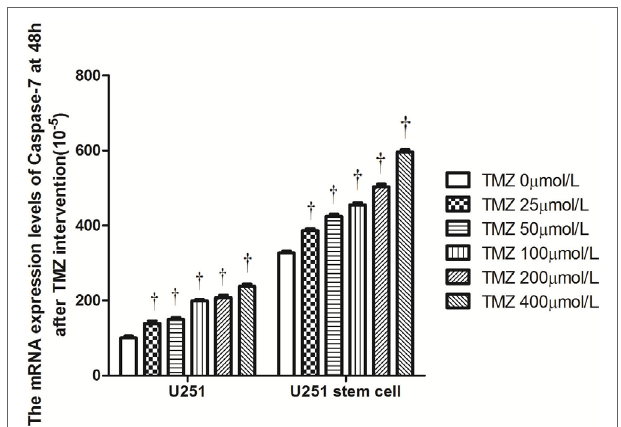
FigUre 9 | The mRNA expression levels of Caspase-7 at 48 h after temozolomide (TMZ) intervention (10 − 5 ) in U251 cells and stem cells. † P < 0.05 compared to the same cells with 0 µmol/L.